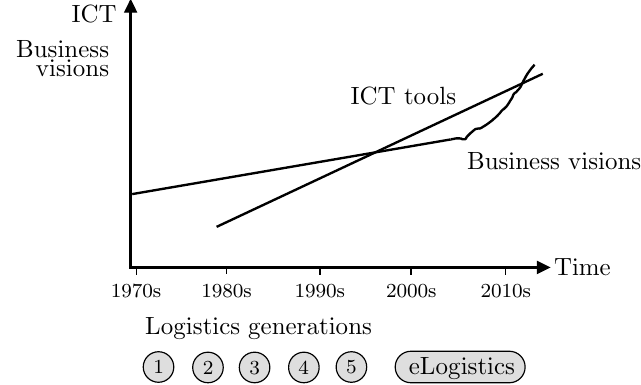
Figure 3: The interaction between visions and tools with an important intersection in 1995 (Ericsson